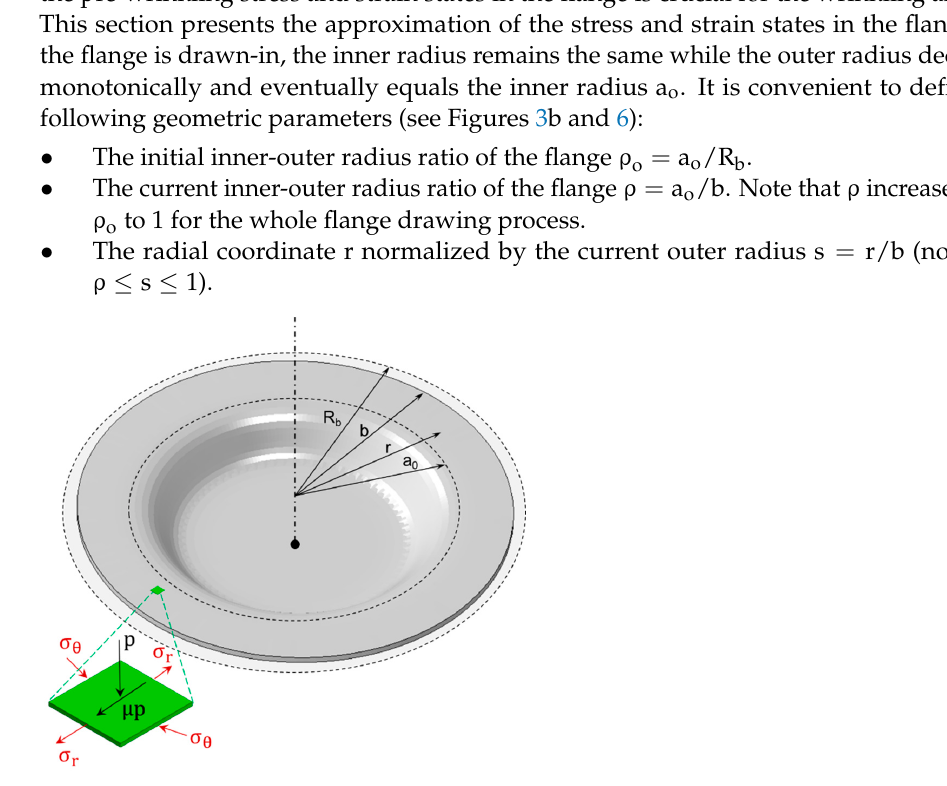
Figure 6. Schematic of the stress state in the flange of a partially drawn cup.